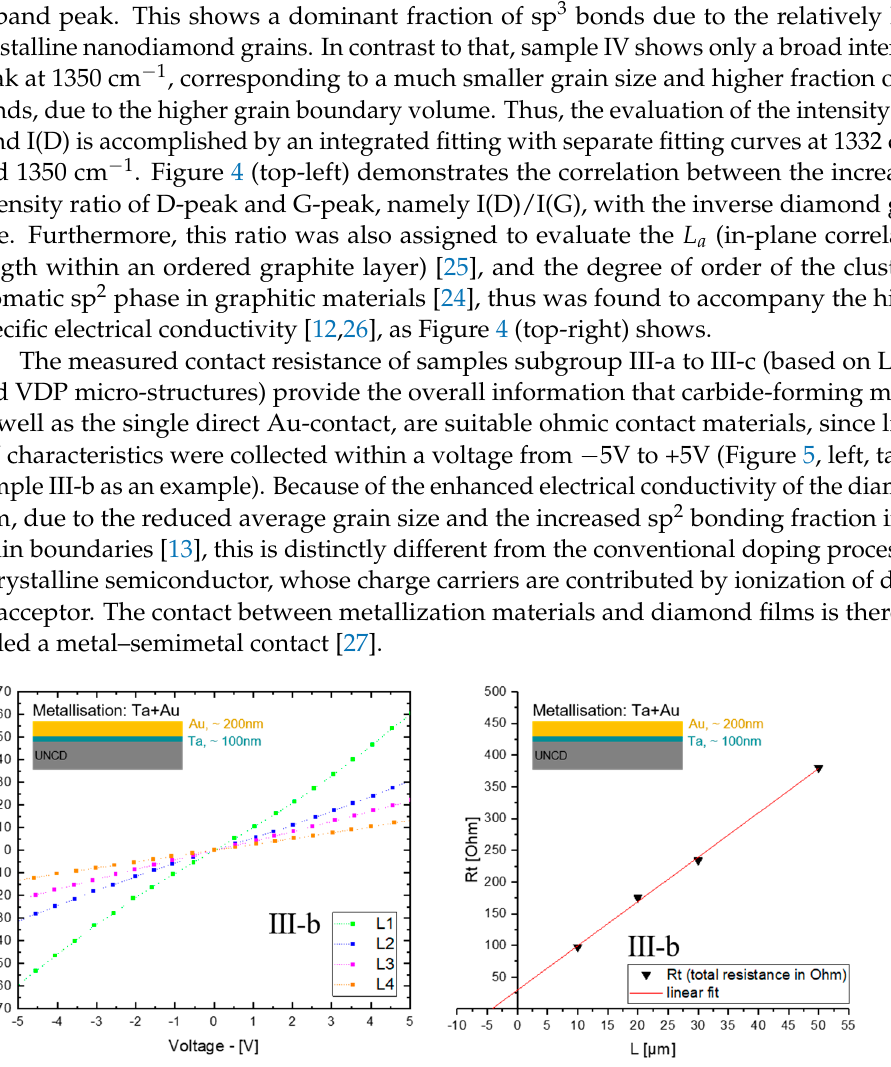
Figure 4. Evaluation of the correlation between the intensity ratio of D-peak and G-peak, namely I(D)/I(G), with diamond grain size (top-left) and with specific electrical conductivity (top-right), based on Raman-spectra (bottom) of four diamond film samples.